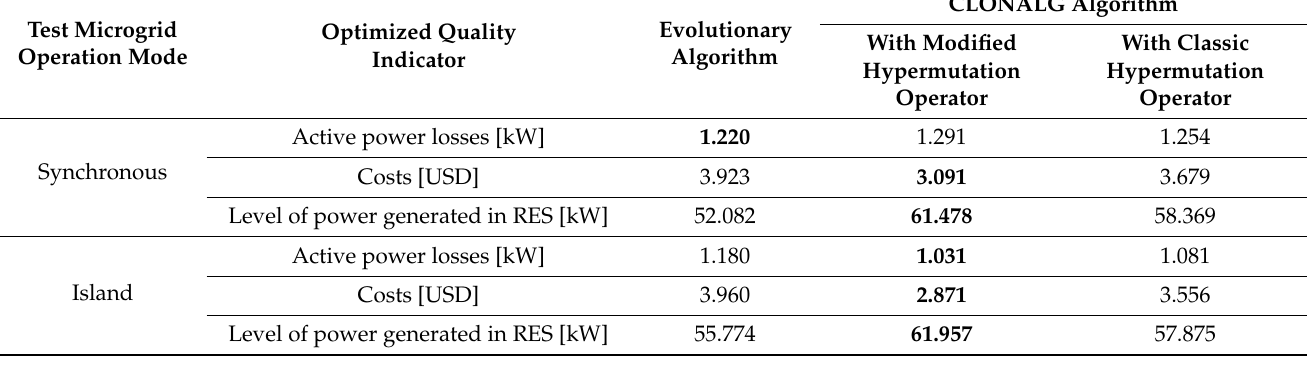
Table 9. Comparison of results of the optimization calculations.